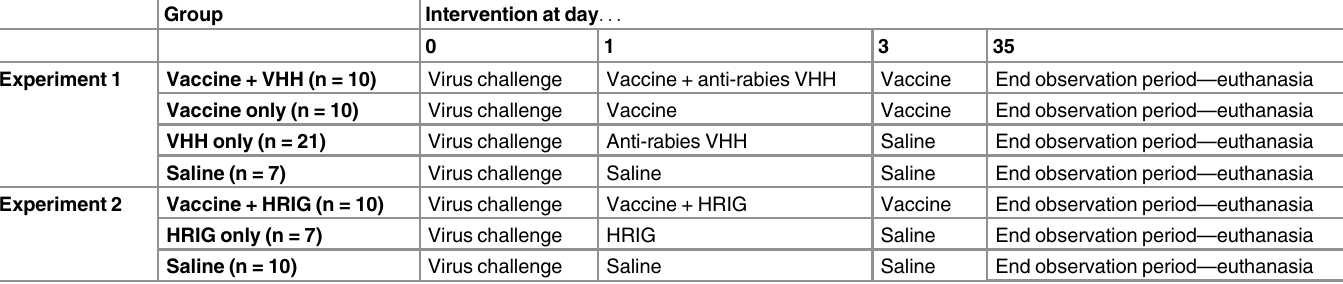
Table 2. Set-up of the post-exposure treatment experiment and interventions in different treatment groups. Group Intervention at day ...